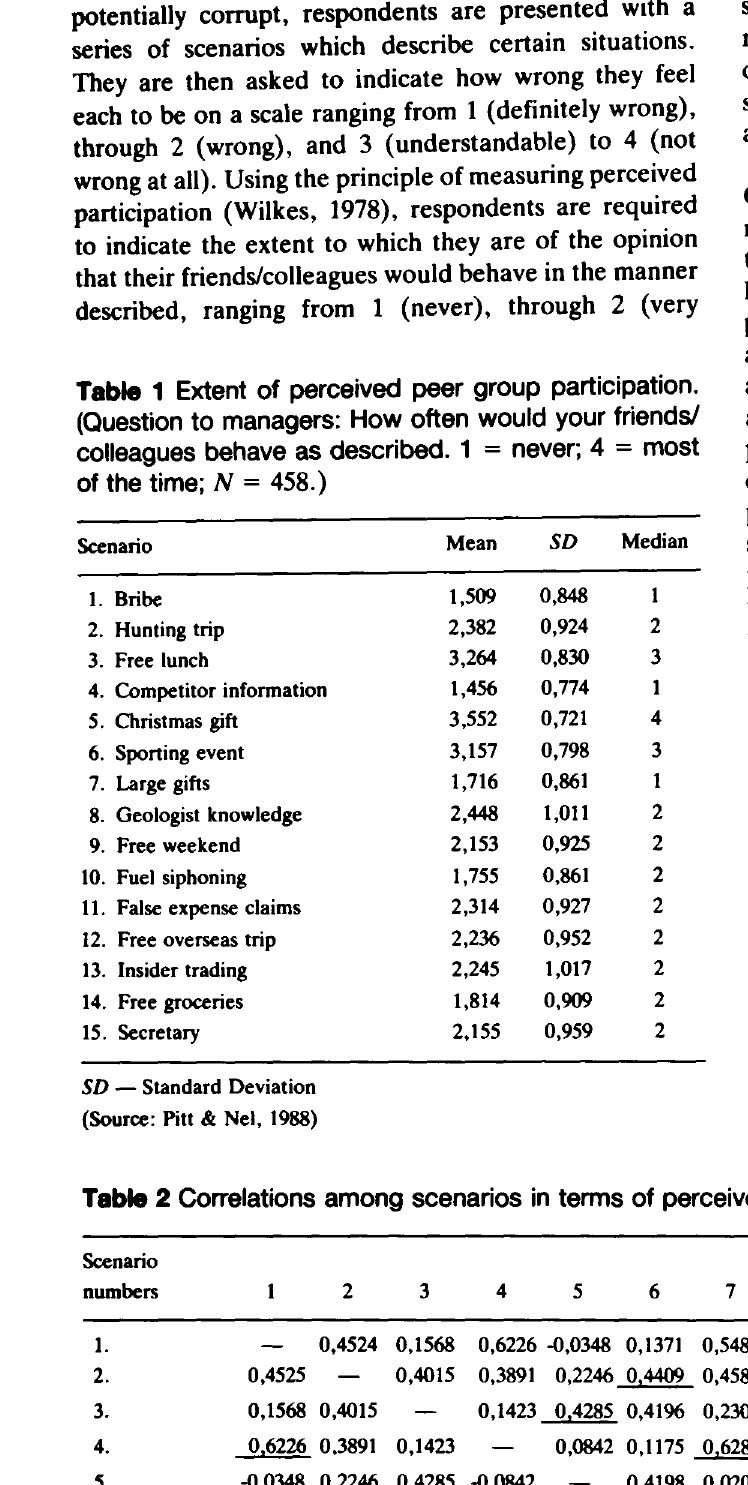
Table 2 Correlations among scenarios in terms of perceived peer group participation